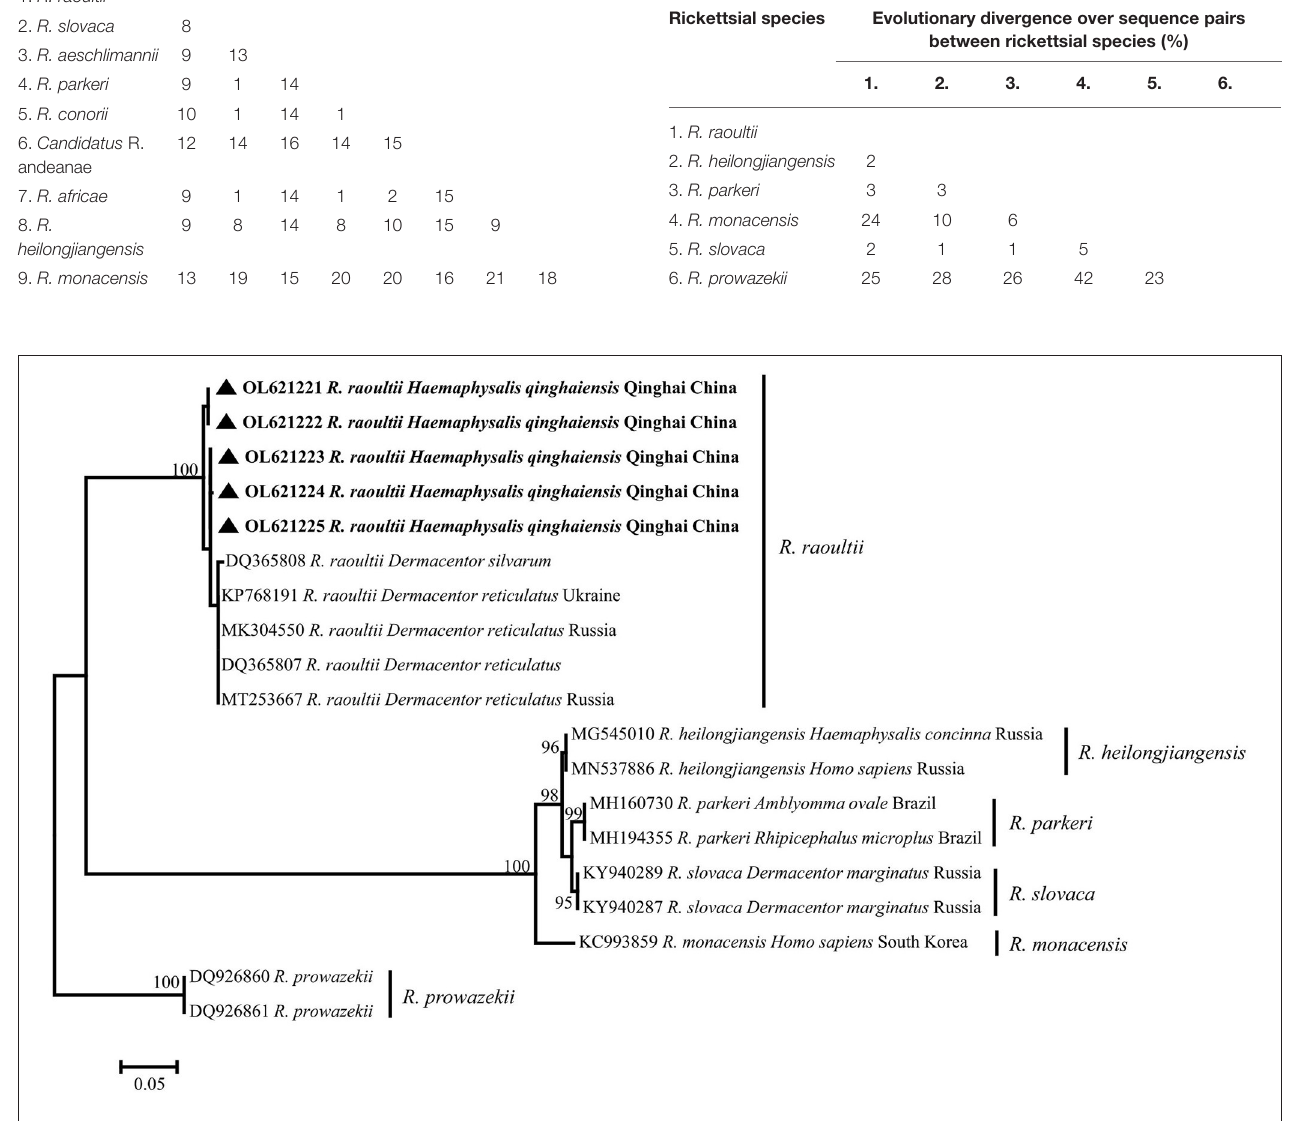
Frontiers in Veterinary Science |